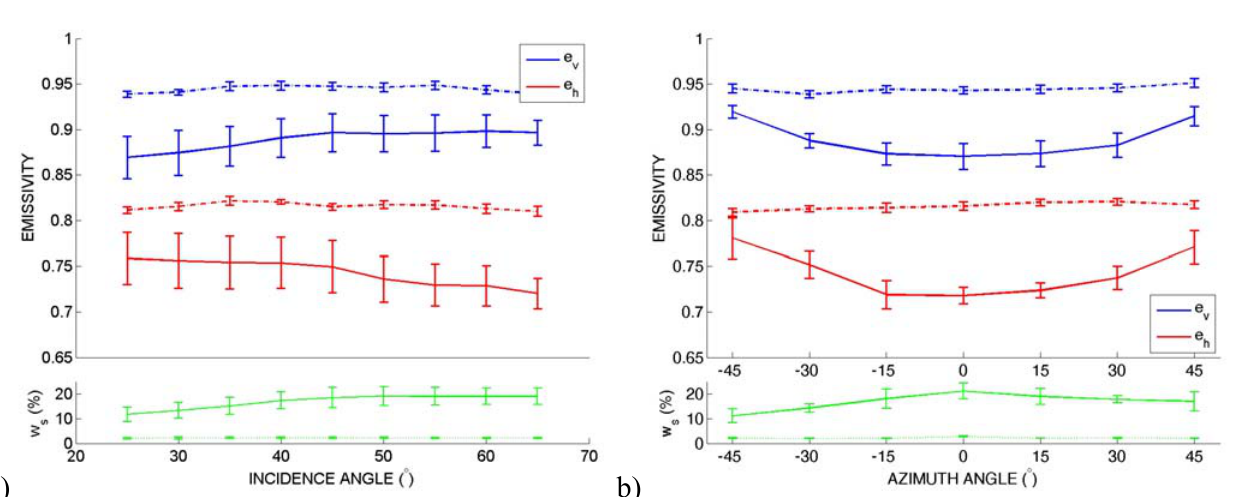
Figure 11. Emissivity at vertical and horizontal polarizations as a function of the incidence and azimuth angles. a) Mean value and standard deviation of the emissivity and of the ground-truth soil moisture as a function of the incidence angle and for all azimuth angles. DoY 185 (solid line) and DoY 181 (dashed-dotted line) have been represented. Blue and red indicate vertical and horizontal polarizations, respectively. b) Mean value and standard deviation of the emissivity as a function of the azimuth angle, for all incidence angles. Blue and red indicate vertical and horizontal polarizations, respectively. Values for two representative days of experiment have been represented: DoY 185 (solid line), and 181 (dash-dotted line). The averaged soil moisture at each observation position has been included (green